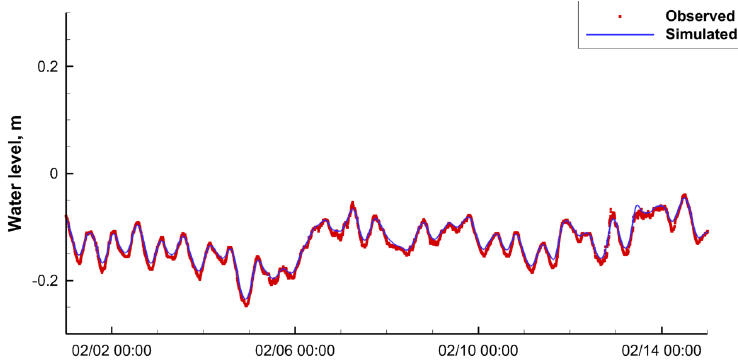
Figure 6. Comparison of simulated (hindcast) and observed water levels at Melbourne station for tidally-dominated flow.